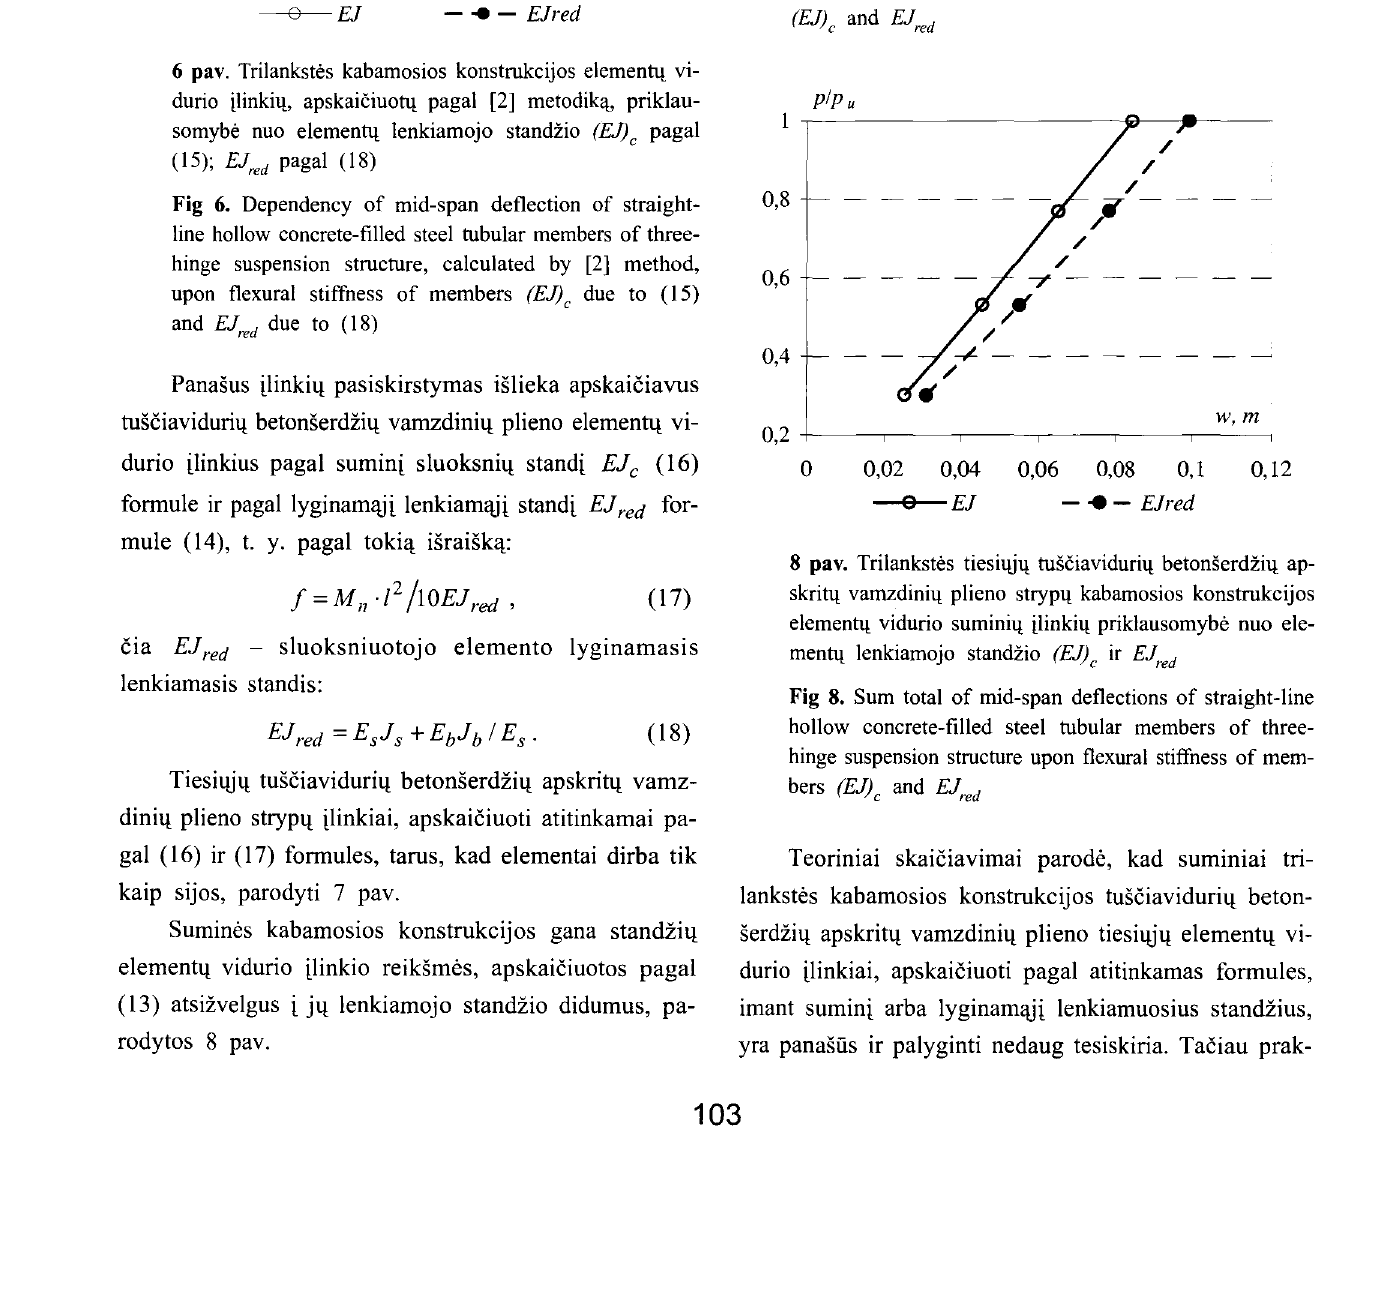
(17) formules, priklausomybe nuo element\! lenkiamojo standzio (EJ) c ir EJred Fig 7. Dependency of mid-span deflection of hollow concrete-filled steel tubular member calculated by for mula ( 16) and ( 17) upon flexural stiffness of members (EJ) c and EJred